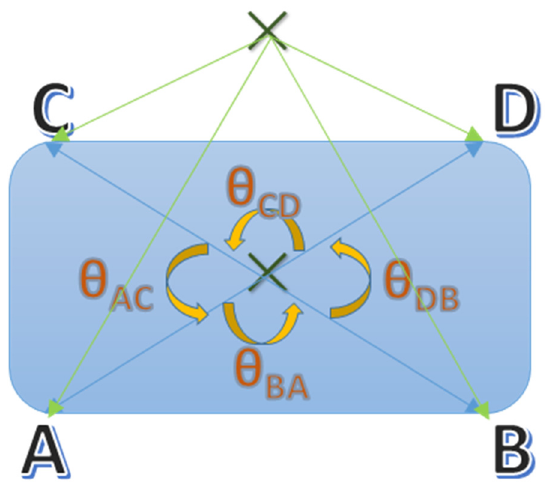
Figure 2. Cell search algorithm.